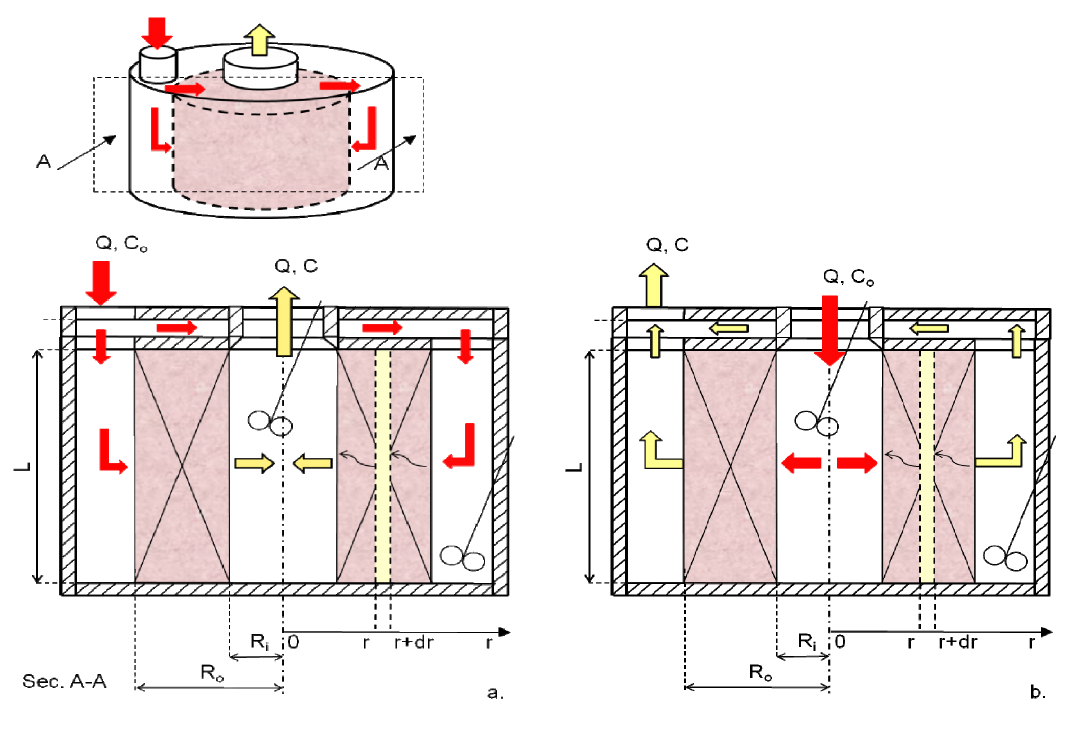
Figure 1. Scheme of radial flow packed-bed bioreactors (rPBBs) with opposite perfusion flows across the annular construct wall: ( a ) inward flow; ( b ) outward